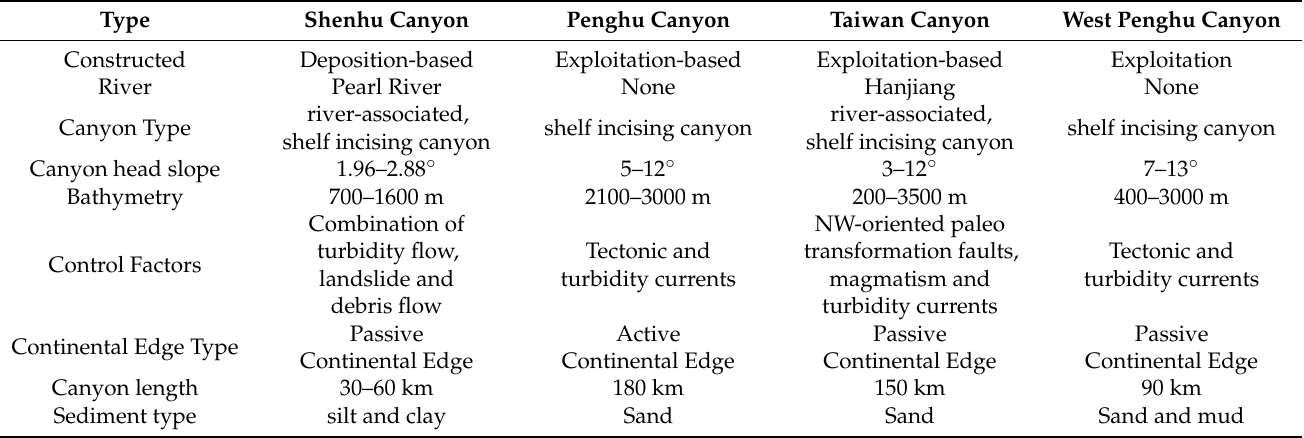
Table 2. Comparison and summary of four submarine canyons in the northern South China Sea